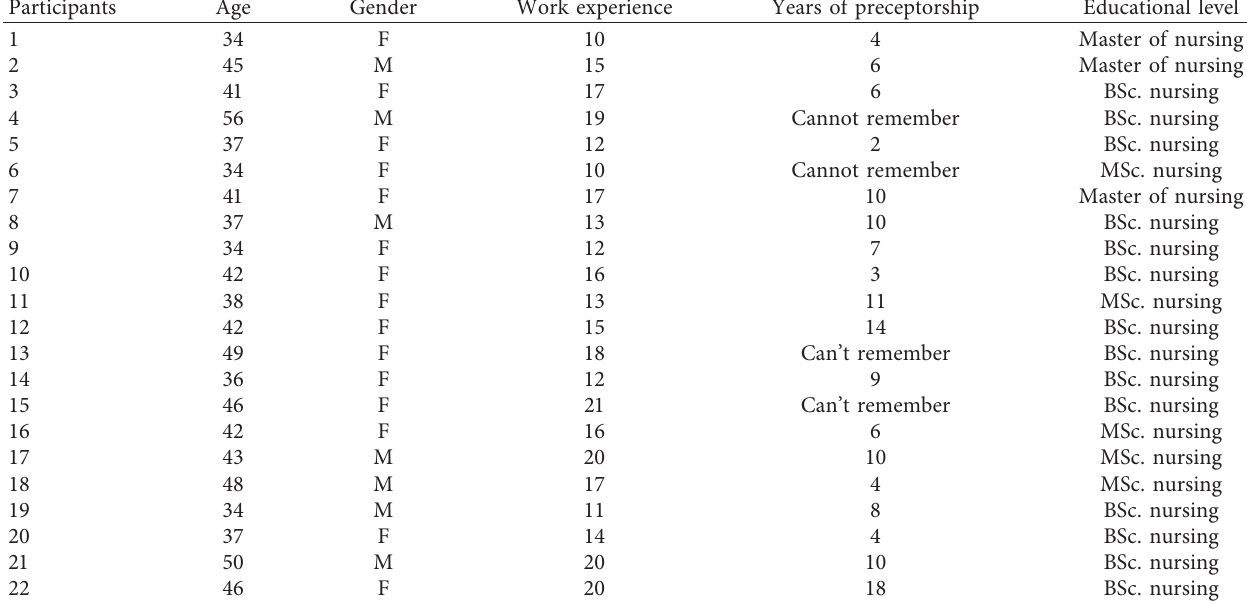
Table 1: Description of participants’ characteristics.